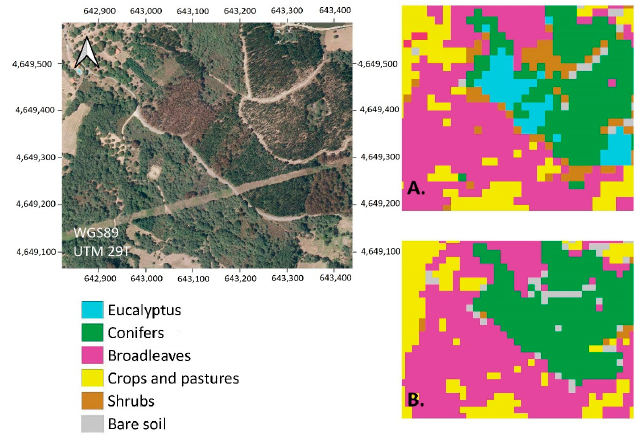
Figure 10. Land cover classification results of contiguous tiles for an overlapping area. ( A – D ) rep- resent the same area. ( A , B ) were obtained using an independent model for each tile. ( A ) represents the results obtained for the TNH tile. ( B ) represents the results obtained for the TPH tile. ( A , B ) are different. ( C , D ) were obtained using one single common model for all of the tiles. ( C ) represents the results obtained for the TNH tile. ( D ) represents the results obtained for the TPH tile. ( C , D ) are quite similar.